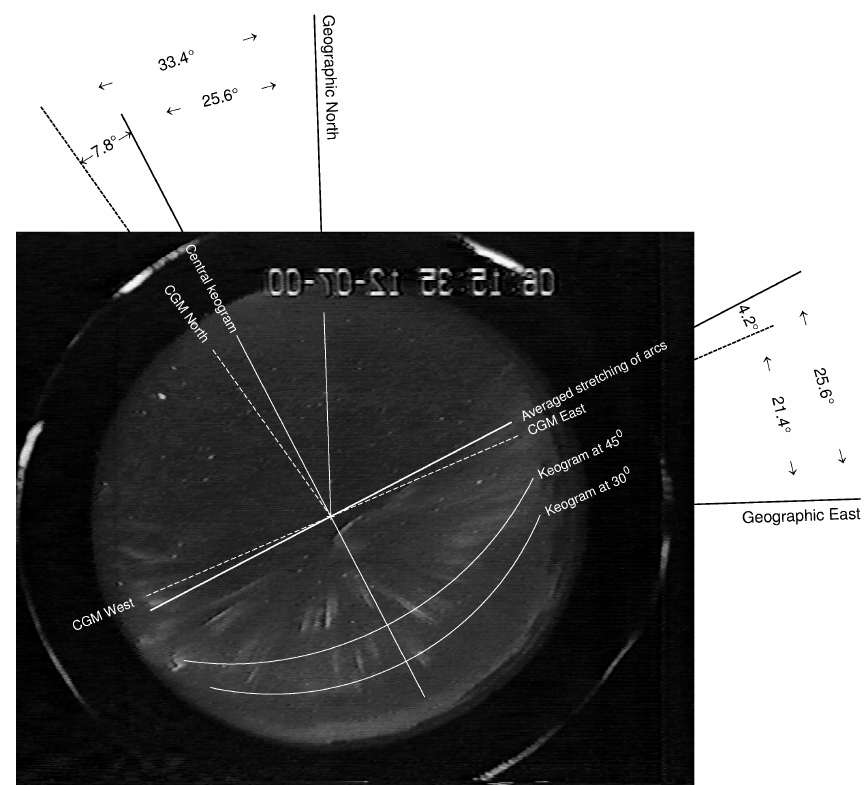
Fig. 4. All-sky TV camera frame demonstrating a typical example of the pre-noon rayed auroral arcs. The averaged orientation of the arcs in both geographic and geomagnetic (CGM) frames is